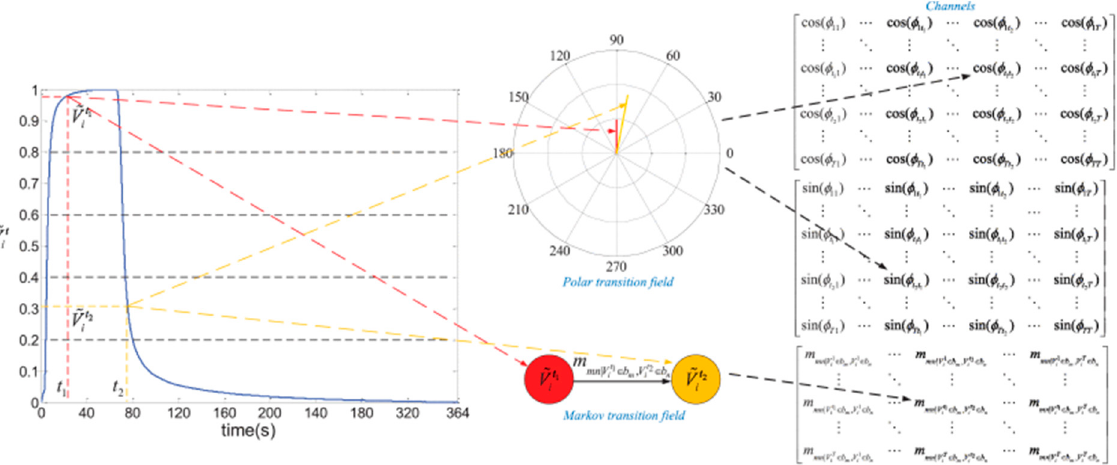
Figure 8. Illustration of encoding sensor response into RGB image [86].